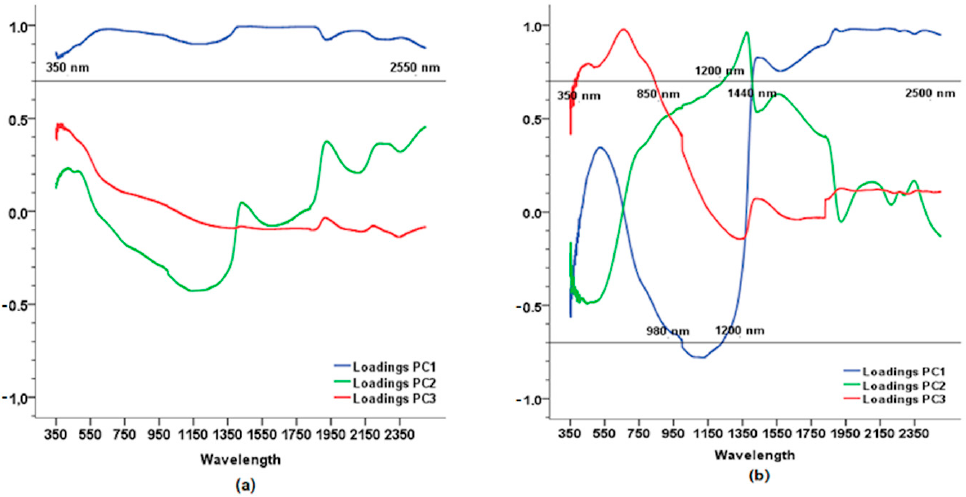
Figure 6. Plot of loadings to first three components using ( a ) raw data, and ( b ) transformed data. The factor structure with raw data is dominated by PC1, a “size factor” with loads greater than 0.8. The other factors have very small loads. Thus, obtaining detailed features is very difficult. The use of transformed data provides the emergence of a more detailed factorial structure. The PC1 factor highlights the NIR interval (1400–2500 nm) as one of the most important features when studying absorption bands of minerals, those being mainly -OH oxidrile (~1400 nm), H 2 O (~1900 nm), and Metal-OH ions (~2200 nm) [6]. By separating the samples, the loads in PC2 show a bipolar factor due to the reflectance in the VIS + NIR and SWR2 intervals (e.g., SB1357) against high values in the full spectrum (e.g., Z239). Plot PC1–PC2 shows that important details of diagnostic features are lost with raw data but transformed data highlight the differences much better, with the visual groups being more homogeneous and consistent. Thus, with raw data, only factor 1 is relevant, it being a “size factor”; the other factors do not practically discriminate (Figure 7a). With the exception of SB1357 and Z215, the transformed data highlight an important relationship between the samples from San Bartolom é and those at the Zarcita dolmen and also establish possible graphic associations (Figure